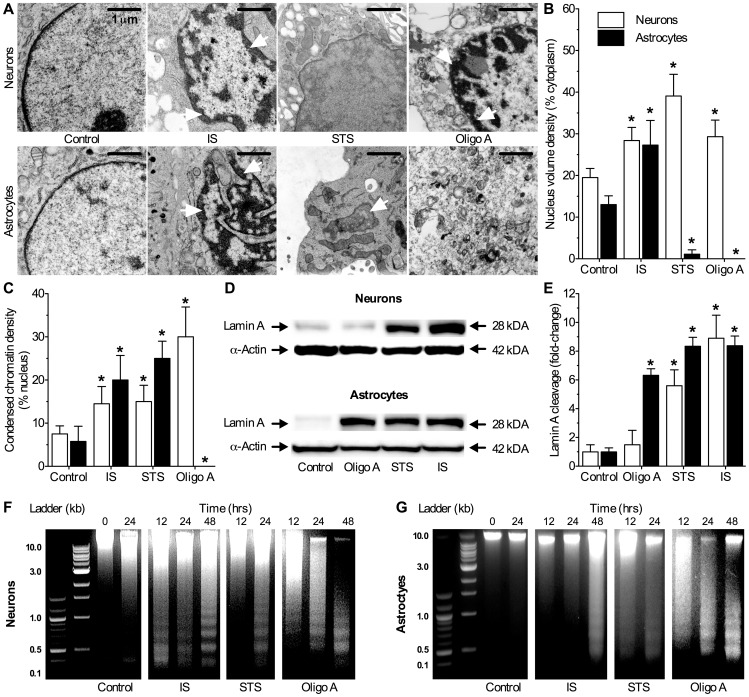
IS-treated nuclei exhibit apoptotic chromatin condensation, nuclear envelope fragmentation into apoptotic bodies, and laddered DNA cleavage.(A) Sample TEM images of nuclei from neurons (upper panels) and astrocytes (lower panels) treated as indicated for 24 hrs. White arrows indicate condensed chromatin beads and fragmenting nuclei. (B) Summary of nuclear volume density from samples in (A). (C) Summary of chromatin volume density from samples in (A). Note: nuclei were too fragmented in oligomycin A-treated astrocytes for quantification. (D) Sample western blots of lamin A cleavage in samples treated as indicated for 6 hrs. Blots are representative of 3 separate experiments. (E) Summary of fold-change in protein expression from (D) normalized to α–actin expression in the same sample. (F&G) Sample conventional agarose gel electrophoresis gel images of DNA fragmentation from neurons (F) and astrocytes (G) treated as indicated for 0, 12, 24, or 48 hrs. Gels are representative of 4 separate experiments. Data are mean ± SEM. Asterisks (*) indicate significant difference from untreated controls (p<0.05).